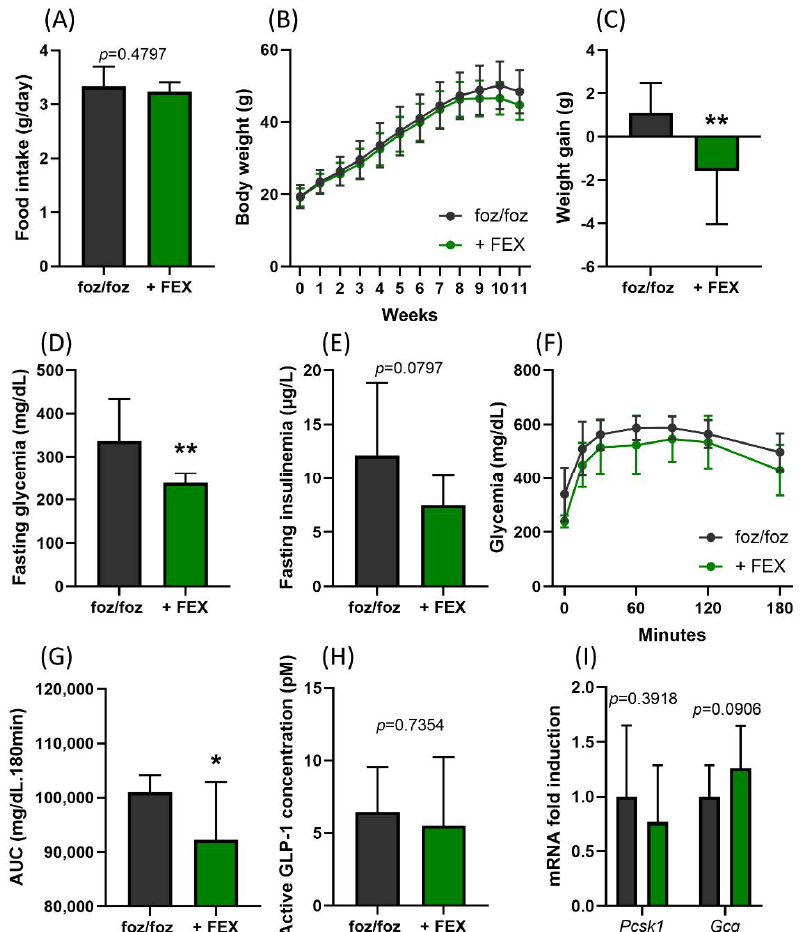
Figure 2. FEX poorly modulates dysmetabolic parameters in mice with NASH. ( A ) Mean food intake, ( B ) body weight evolution, ( C ) body weight gain over the 3 weeks of treatment, ( D ) fasting glycemia and ( E ) fasting insulinemia of foz/foz and foz/foz + FEX mice. ( F ) Glycemia during the OGTT performed at the end of the experiment and ( G ) AUC for the OGTT. ( H ) Plasmatic active GLP-1 concentrations 30 min after the glucose challenge. ( I ) Gene expression of prohormone convertase 1 ( Pcsk1 ) and proglucagon ( Gcg ) in the colon of foz/foz and foz/foz + FEX mice (n = 11–13/group). Mean ± SD. Two-way ANOVA followed by post hoc Bonferroni correction; and Student’s t test. Statistical significance is represented by * p < 0.05 and ** p < 0.001.